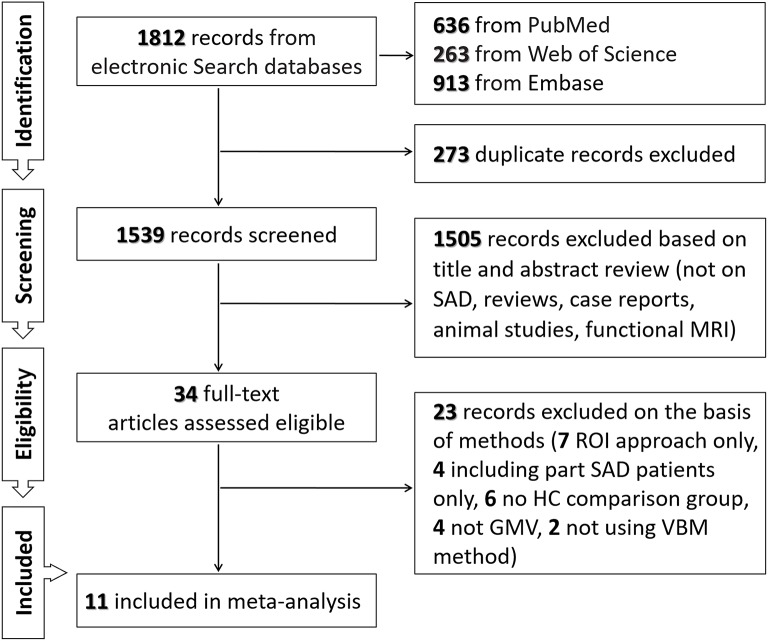
Flowchart of the search strategy and inclusion of studies.